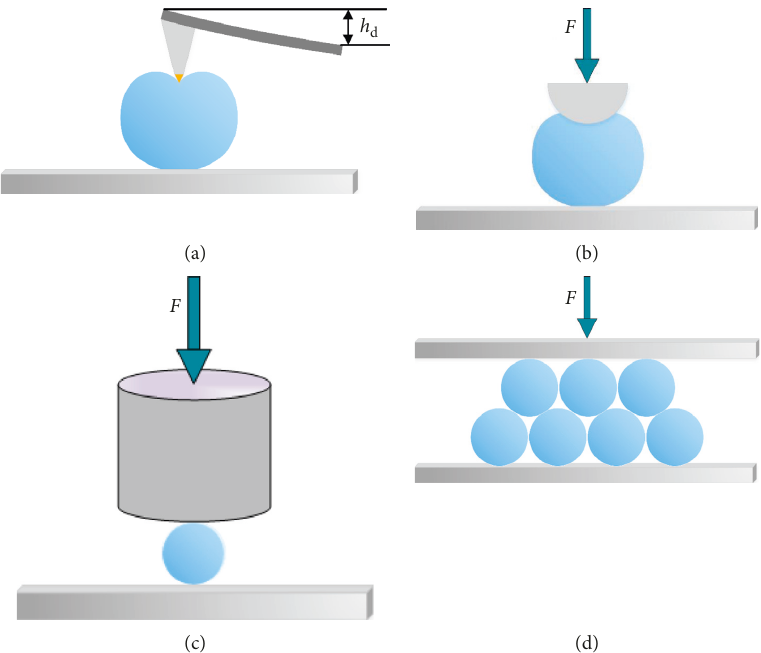
Figure 6: Schematic diagram of microcapsule mechanical properties testing: (a) atomic force microscopic analysis, (b) micro-nano- indentation detection, (c) micromanipulation system, and (d) multiple microcapsules between two plates.